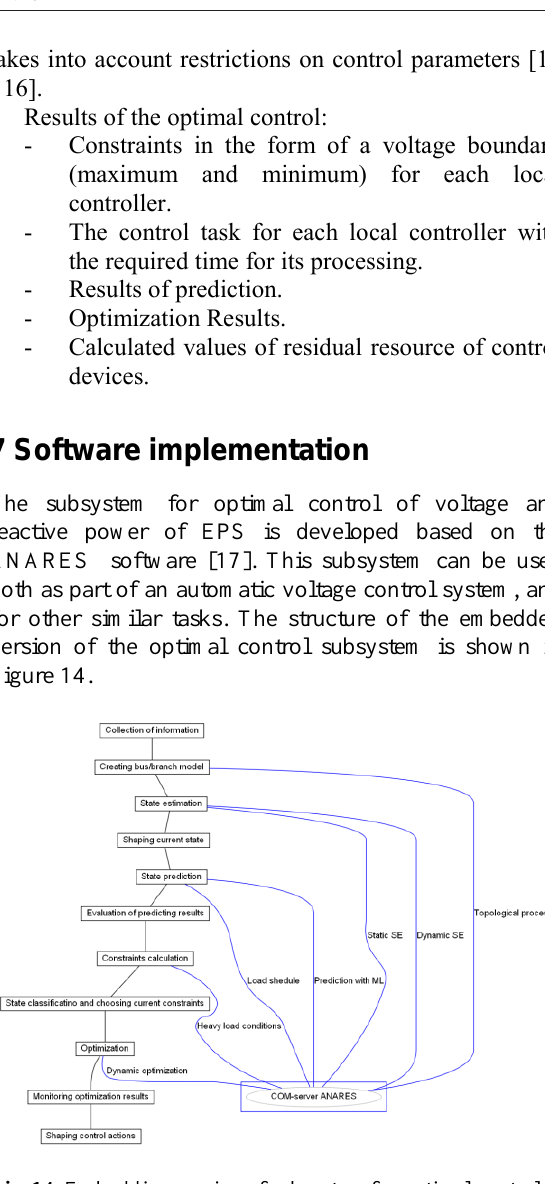
Fig. 14. Embedding version of subsystem for optimal control of